Question: Condense the content of this figure into a single sentence.
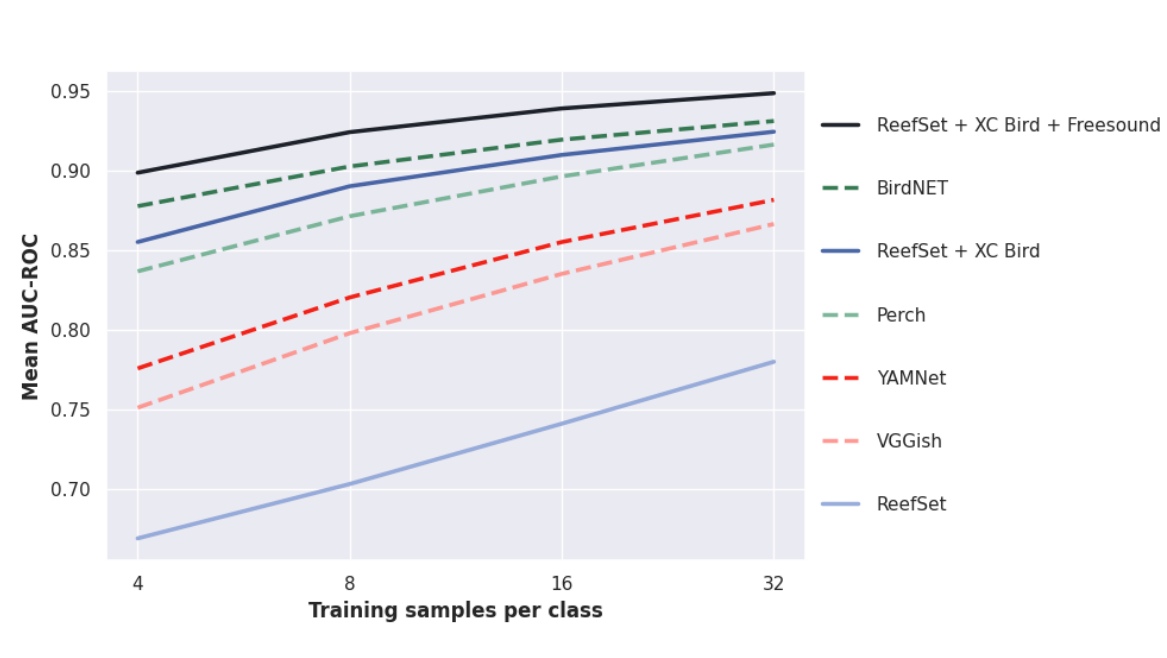
Answer: Mean AUC-ROC scores reported by transfer learning evaluation for each model across all 16  datasets within ReefSet. Dashed lines represent existing pretrained networks, with names indicated in  the legend. Thick lines represent our alternative pretraining strategies, with the data used for  pretraining indicated in the legend.